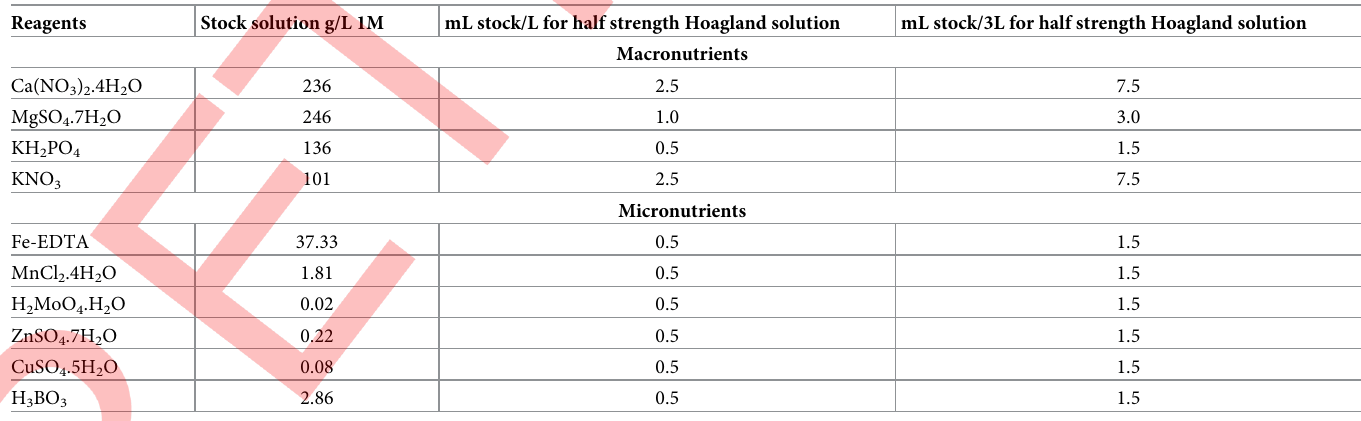
Table 2. Composition of Hoagland solution used in this experiment.